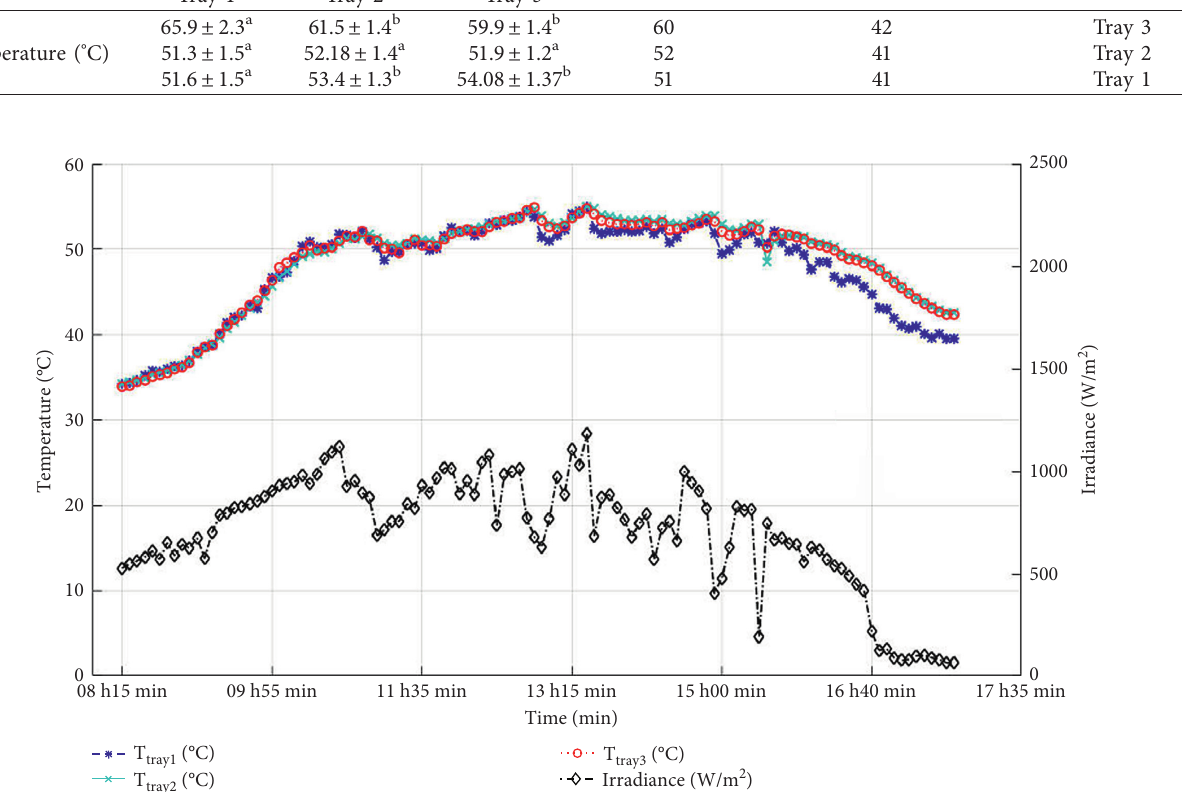
Figure 10: Temperature and irradiance profiles in linking mode.